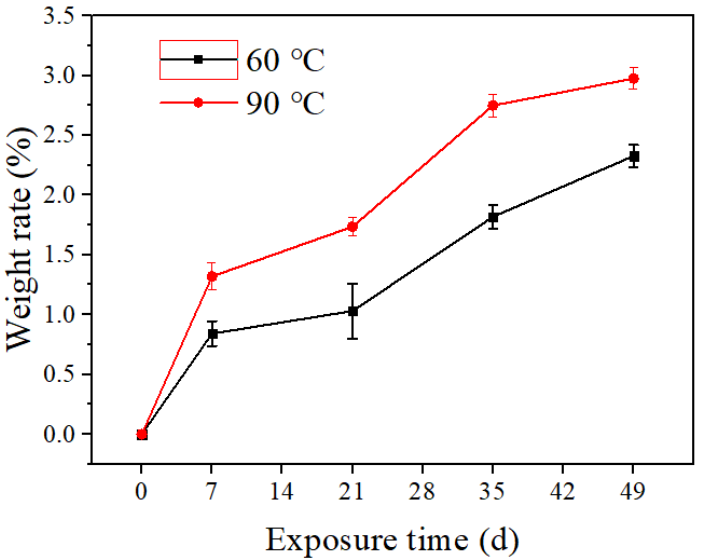
Figure 2. The weight change of PVDF after the exposure